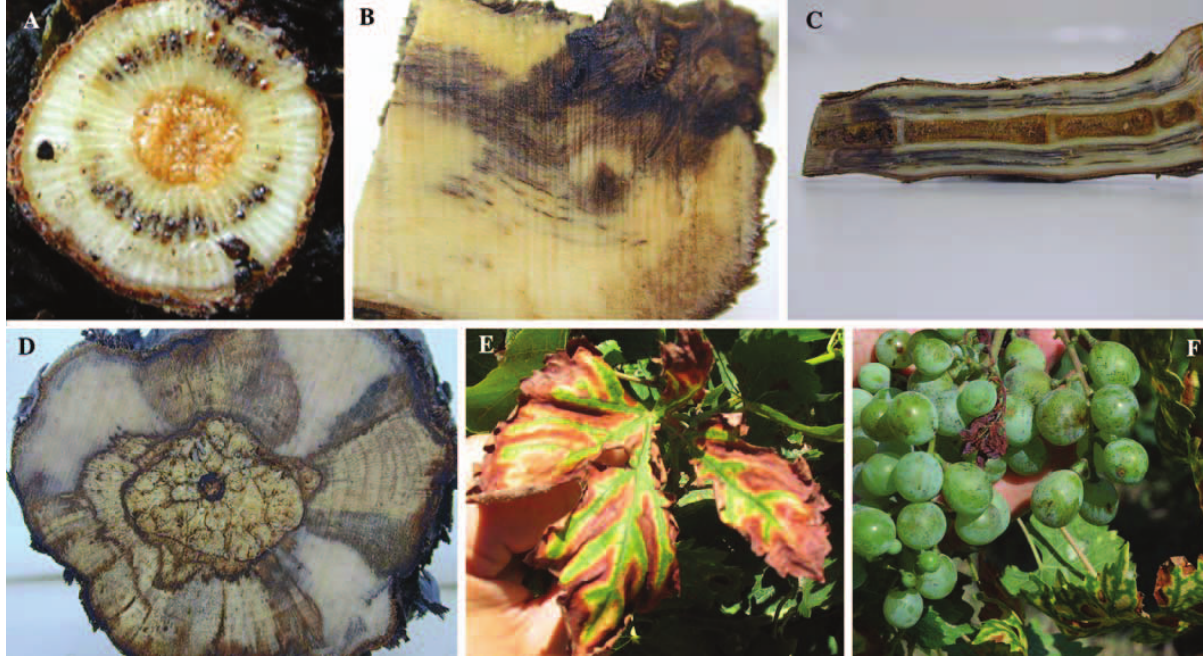
Fig. 2. Micromorphology of three Phaeoacremonium species. A and B. Type III phialides of Pm. aleo- philum . C. Conidiophore of Pm. parasiticum with the basal cells being distinctly darker pigmented. D. Myce- lium showing prominent warts associated with Pm. parasiticum . E and F. Co- nidiophores with type III phialides and type II phial- ides of Pm. viticola . Of the three species illustrated here, Phaeoacremonium viticola has the longest collarettes (indicated by an arrow at the apex of a phi- alide) of up to 2.5 mm. Scale bars = 10